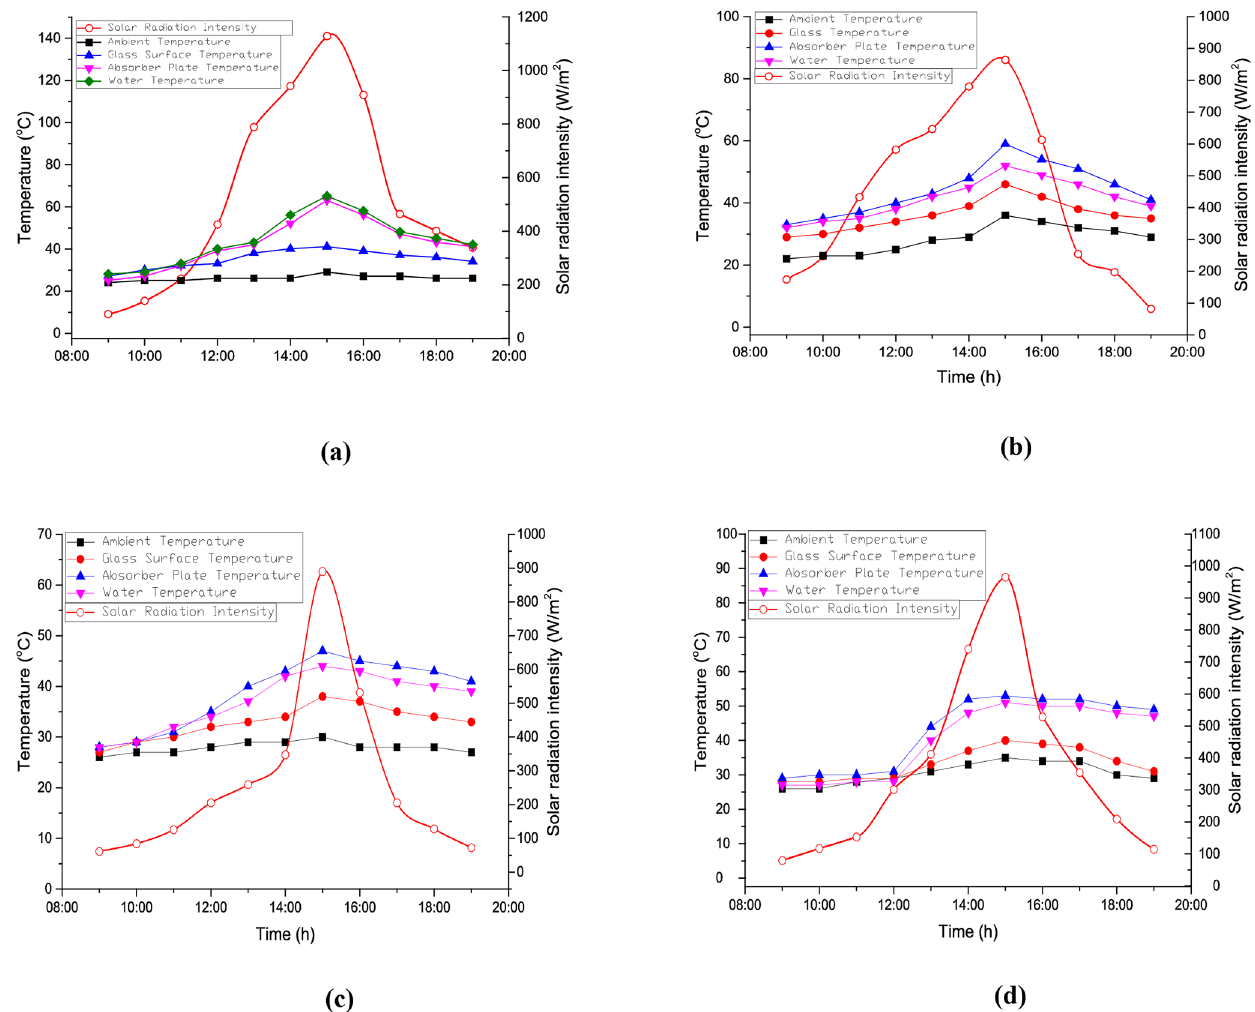
Figure 3. Daily temperature variation with solar radiation intensity. (a) Day 1, (b) day 3, (c) day 6 and (d) day